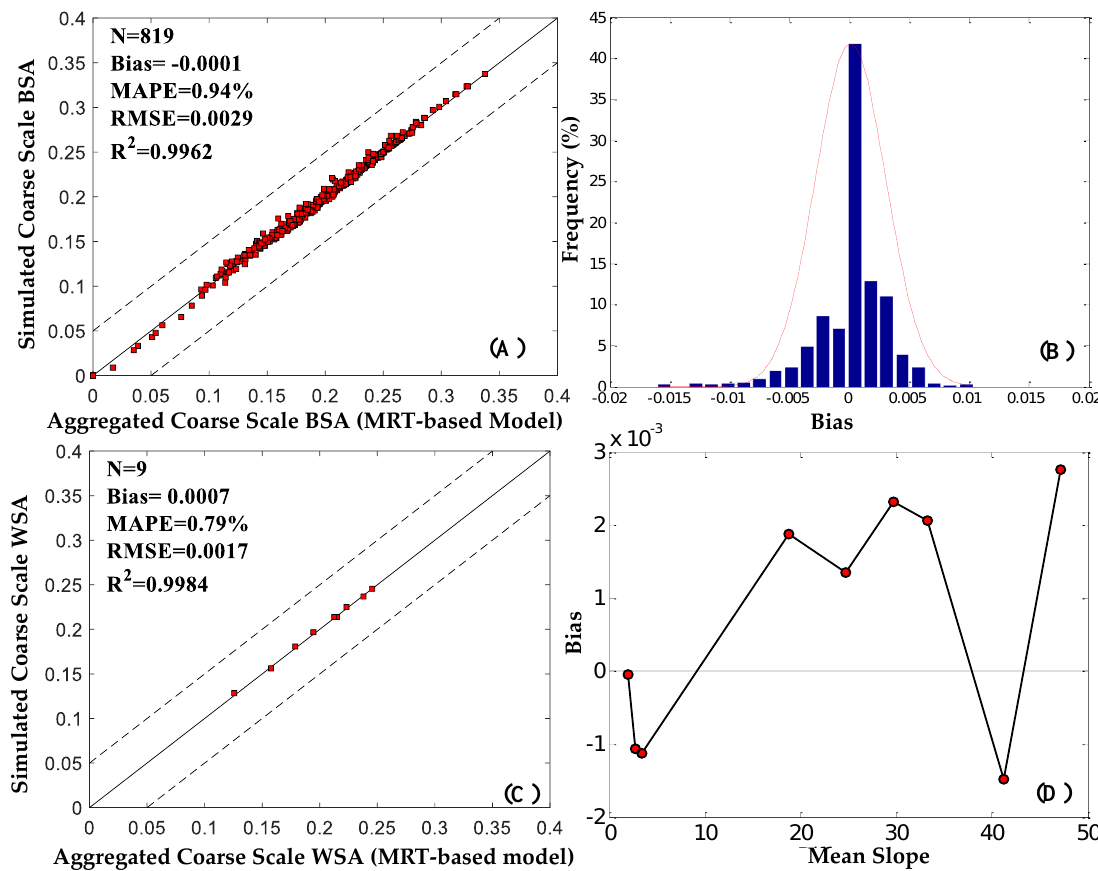
Figure 5. Scatter plots and the histogram evaluate the aggregated coarse scale albedo (using a Mountain- Radiation-Transfer (MRT)-based model) against the reference simulated coarse scale albedo for ( A ) the aggregated coarse scale BSA vs. the simulated coarse scale BSA; ( B ) the bias histogram of the aggregated coarse scale BSA minus the reference coarse scale BSA; ( C ) the aggregated coarse scale WSA vs. the simulated coarse scale WSA; and ( D ) the bias between the nine aggregated coarse scale WSAs and the reference simulated WSAs following the increase of the mean